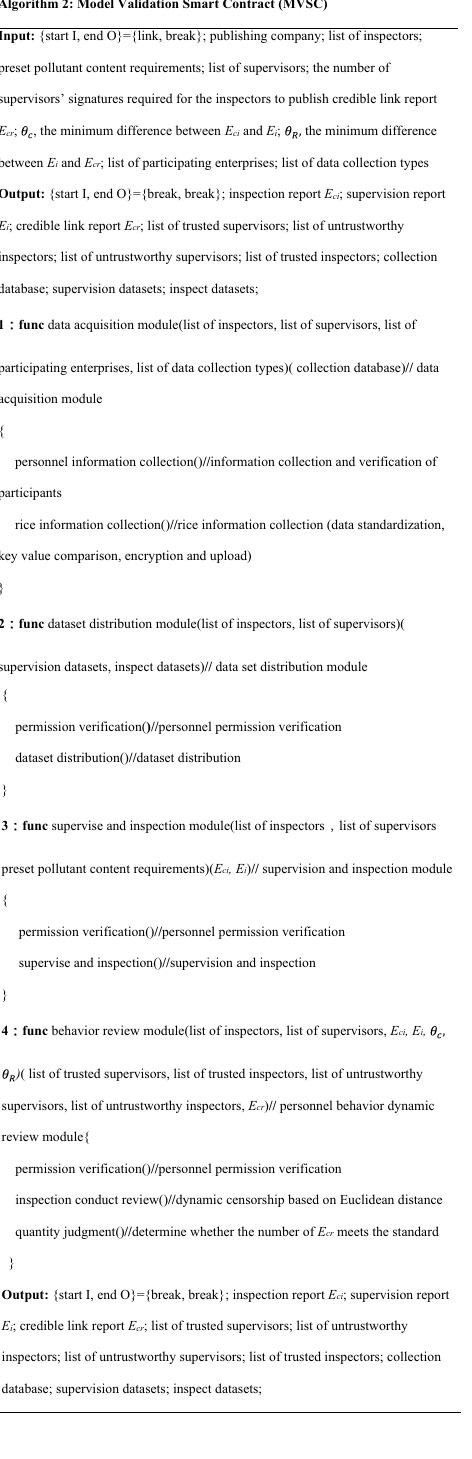
Algorithm 2: Model Validation Smart Contract